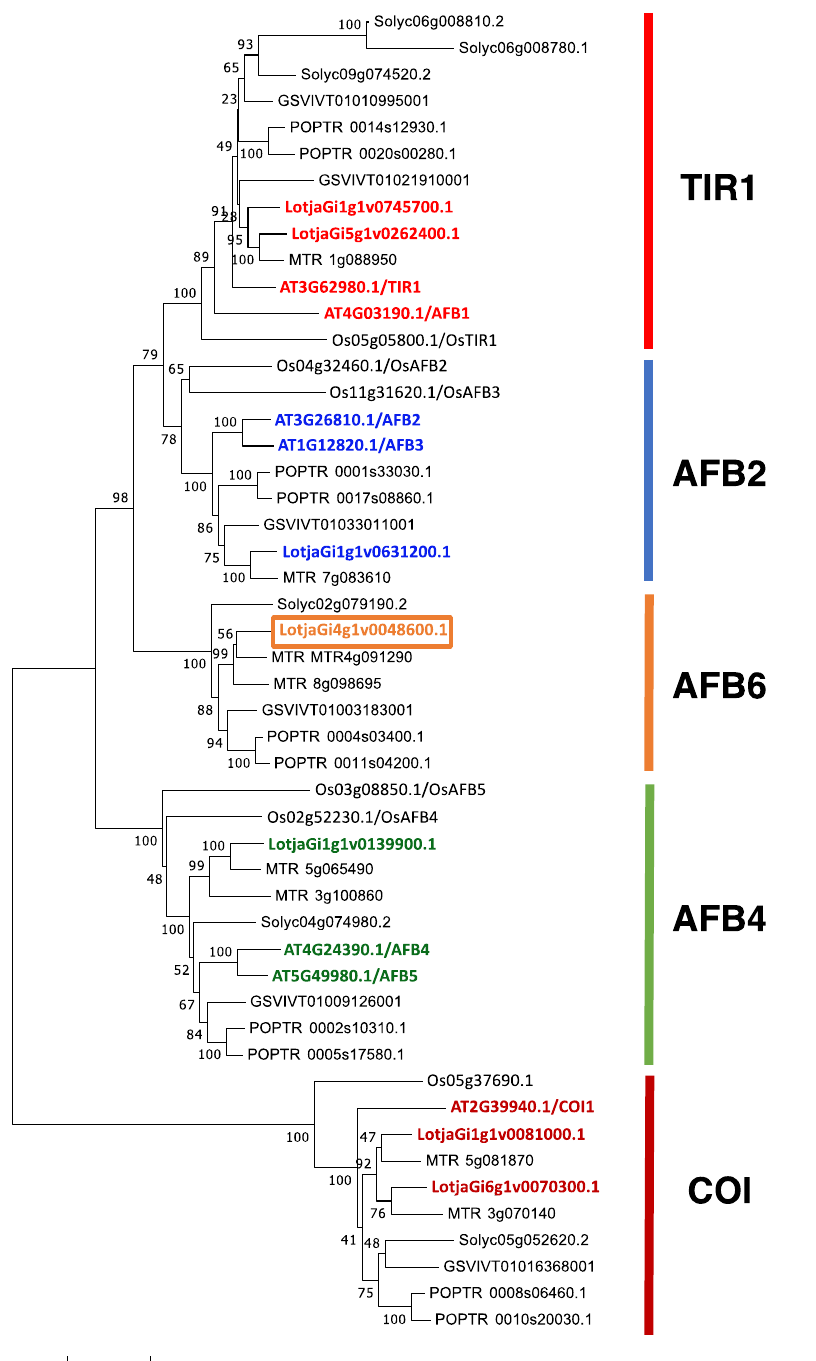
Figure 1. The evolutionary relationship between plant TIR/AFB members. The evolutional history was inferred using the Neighbor-Joining method [39]. The optimal tree with the sum of branch length = 8.90683588 is shown. The tree is drawn to scale, with branch lengths in the same units as those of the evolutionary distances used to infer the phylogenetic tree. The evolutionary distances were computed using the JTT matrix-based method and are in the units of the number of amino acid substitutions per site. The five distinct clades of the TIR/AFB family are indicated by different bar colours on the right. L. japonicus and A. thaliana members are highlighted by colours. The LjAFB6 member is